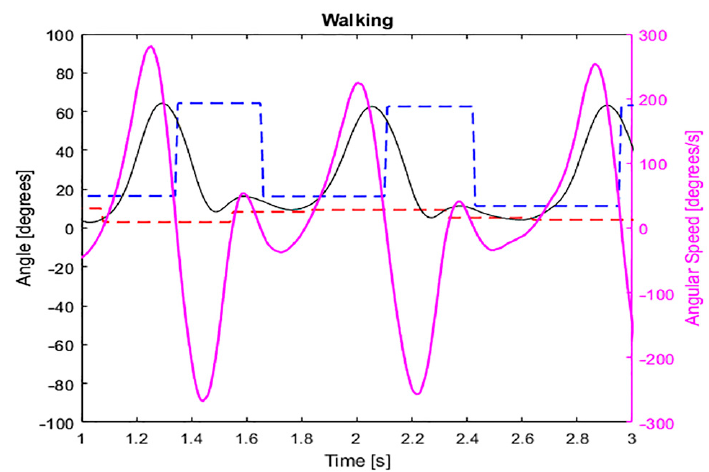
Figure 4. Knee’s angle (black continuous), angular speed (pink continuous), maximum (blue dashed line) and minimum angle (red dashed line) in the activity of walking.